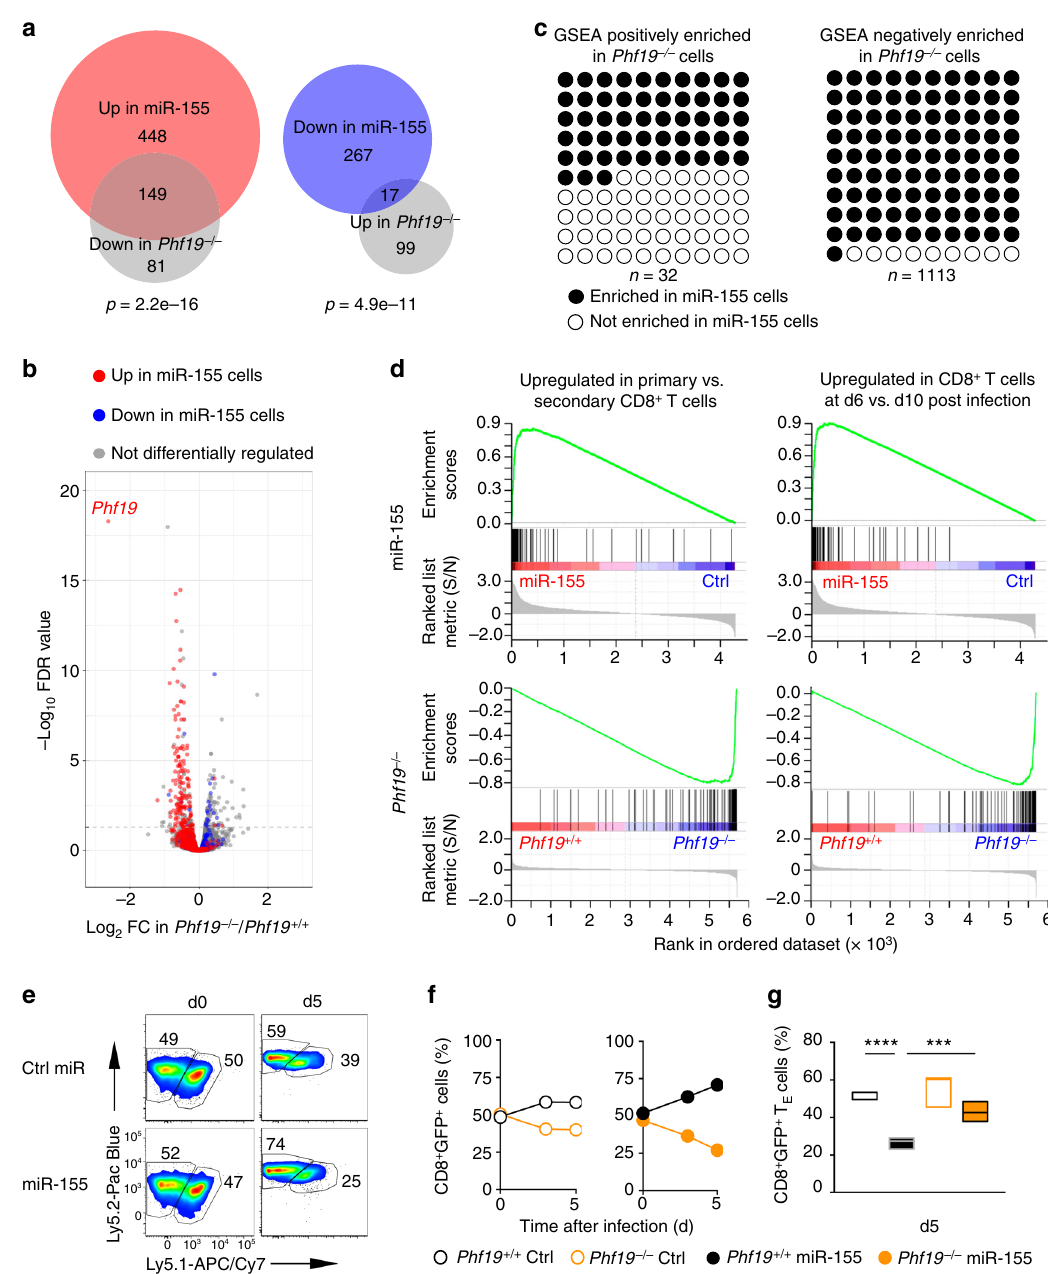
Fig. 6 Phf19 is a critical downstream factor of miR-155 in CD8 + T cells. a Venn diagrams and b volcano plot depicting the number of overlapping differentially expressed genes between differentially expressed genes in miR-155-overexpressing and Phf19 − / − KLRG1 − CD62L − CD8 + T cells. Gene expression was evaluated by RNA-seq of pmel-1 KLRG1 − CD62L − CD8 + T cells 5 days after adoptive transfer of 3 × 10 5 pmel-1 Phf19 + / + / Phf19 − / − cells or pmel-1 cells overexpressing Ctrl-miR/miR-155 into wild-type mice in conjunction with gp100-VV. RNA-seq data were obtained from triplicated groups of three individual mice. c Gene sets signi fi cantly enriched (FDR < 0.25) in Phf19 − / − CD8 + T cells. Gene sets also enriched in miR-155 overexpressing cells are highlighted in black. d Enrichment of genes upregulated in CD8 + T cells responding to primary vs secondary LCMV infections 43 (left panels) and enrichment of genes upregulated in CD8 + T cells at d6 vs d10 post LmOVA infections 45 (right panels) in miR-155-overexpressing and Phf19 − / − CD8 + T cells. e Flow cytometry analysis of congenically-distinguishable live pmel-1 Phf19 + / + Ly5.2 + / + and pmel-1 Phf19 − / − Ly5.1 + / − cells transduced with either miR-155 or Ctrl-miR assessed pre-transfer and 5 days after co-transfer of 3 × 10 5 cells into wild-type mice in conjunction with gp100-VV administration. Numbers adjacent to outlined areas indicate percentage after gating on live CD8 + GFP + T cells. f , g Percentages of live pmel-1 CD8 + GFP + T cells transduced with Ctrl-miR (left panel) or miR-155 (right panel) ( f ) and CD8 + GFP + T E cells ( g ) at indicated time points after transfer as described in e . Symbols represent the mean ± s.e.m. of three individual mice; small horizontal lines (right panel) indicate the mean ± s.e.m. Data are representative of two independent experiments. *** P < 0.005; **** P < 0.001 (unpaired two-tailed Student ’ s t